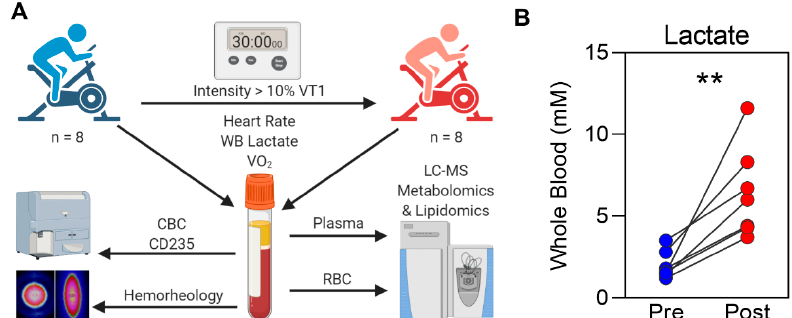
Figure 1. A cycling test to determine responses in metabolism and red blood cell (RBC) properties. ( A ) Eight well-trained male cyclists participated in a 30 min submaximal cycling test (greater than 10% ventilatory threshold 1 (VT1) on an ergometer). In addition to measurement of physiological parameters, whole-blood samples were taken for complete blood counts (CBC) and lactate measurement. Samples were separated into plasma and RBC components. In addition to mass-spectrometry-based lipidomics and metabolomics, RBC samples were also assessed for glycophorin A (CD235) content, deformability, and aggregation properties using ektacytometry. ( B ) Whole-blood (WB) lactate measurements (** p < 0.01).